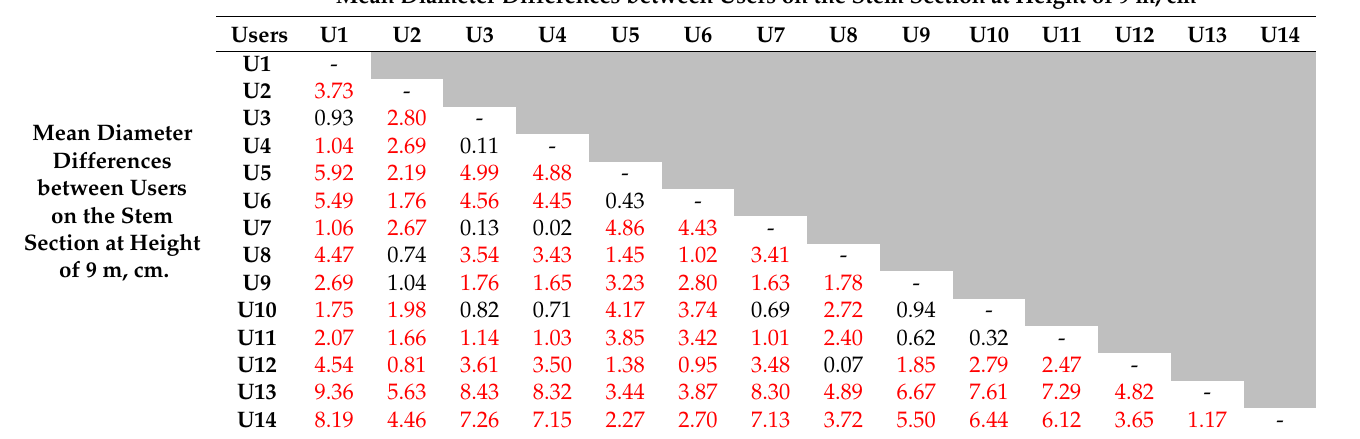
Table A5. Differences between mean diameters obtained by each user when a laser caliper was used to measure upper-stem diameters at a height of 9 m. The red values denote significant differences between the mean diameters obtained by the users.